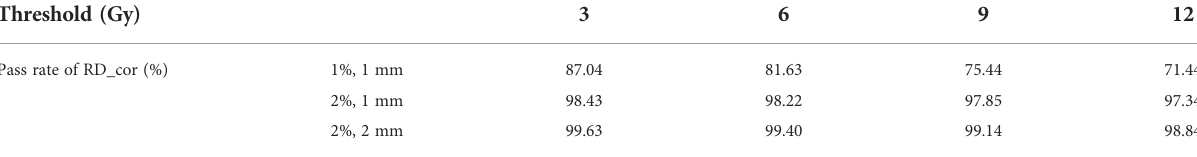
TABLE 3 g pass rates for RD_cor for the phantom. The second column indicates the distance and dose difference criteria. Threshold (Gy)